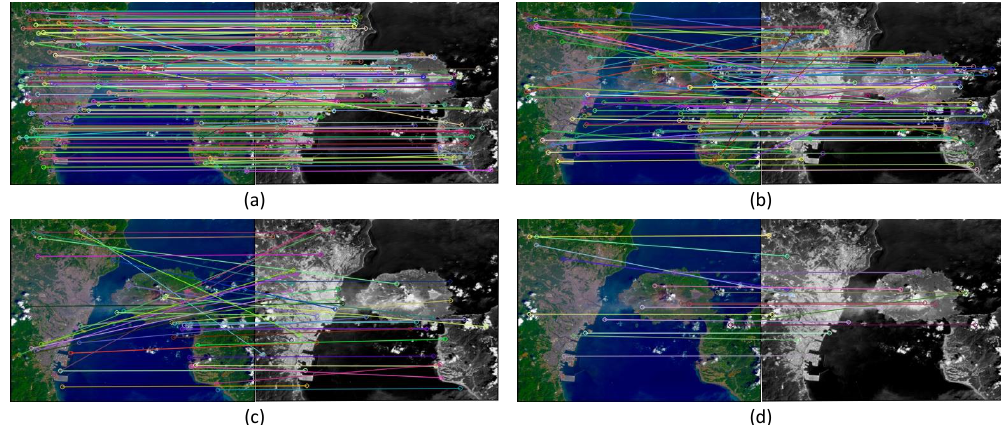
Figure 1. The example of resurrection. ( a ) The mappings whose cg is three in Step